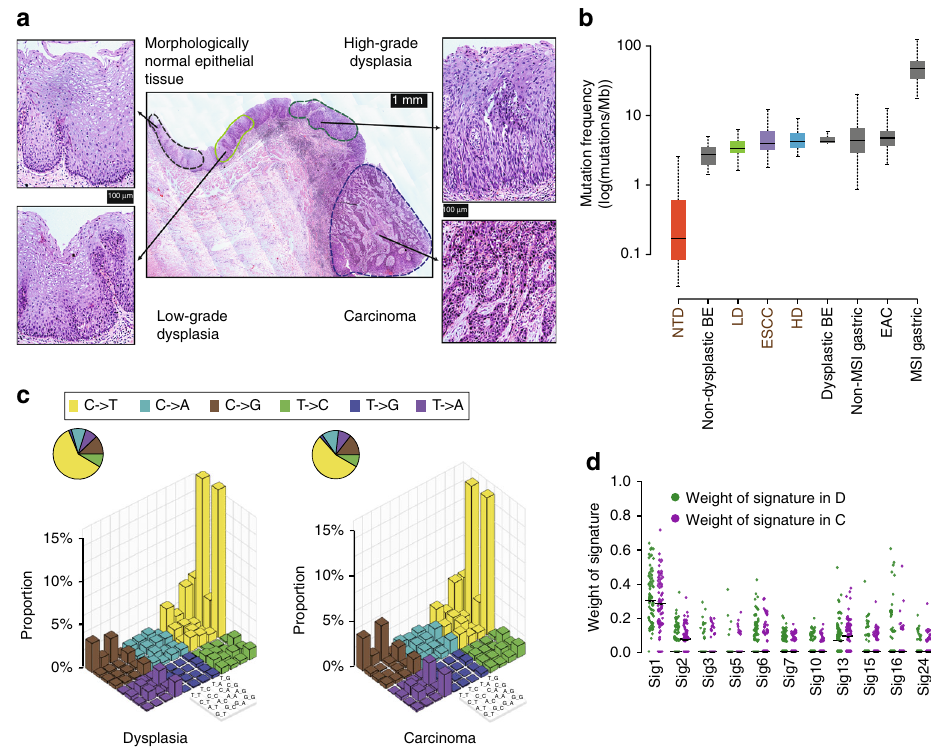
Fig. 1 Mutational density and context of all samples. a Diagram showing the hematoxylin- and eosin-stained sections of morphologically normal epithelial tissue, low-grade dysplasia (LD), high-grade dysplasia (HD), and invasive esophageal squamous cell carcinoma (ESCC) from the same case. Scale bars are indicated. b Comparison of the mutational density of all NTDs ( n = 13), LDs ( n = 44), HDs ( n = 31), and ESCCs ( n = 62) with several other types of cancer. Non-dysplastic BE, non-dysplastic Barrett ’ s esophagus ( n = 14); dysplastic BE, dysplastic Barrett ’ s esophagus ( n = 11); EAC, esophageal adenocarcinoma ( n = 183); MSI Gastric, microsatellite instable gastric cancer ( n = 64); non-MSI Gastric, non-microsatellite instable gastric cancer ( n = 231) 47 . The y -axis is shown on a log 10 -transformed scale. In each box plot, the lower and upper limits of the box denote the 25th (Q1) and 75th (Q3) percentiles, and the median value is indicated. The upper and lower whiskers show Q3 + 1.5 × IQR (interquartile range) and Q1 − 1.5 × IQR, respectively. c ‘ Lego ’ plots displaying the frequency of base substitutions within speci fi c trinucleotide mutational contexts in all dysplasia samples ( left ) and ESCCs ( right ). d The weight of decomposed signatures in each of ESCCs ( purple dots ) and dysplasia samples ( green dots ). The mean value is indicated. C, ESCCs; D, dysplasia